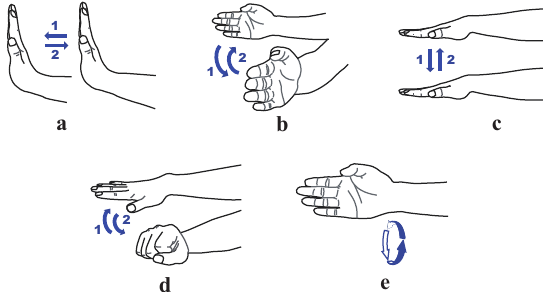
Figure 2. The five hand gestures: ( a ) pushing and pulling (PP), firstly pushing your hand to the front and then pull it back; ( b ) waving left and right (WLR), firstly waving your hand to the left and then to the right; ( c ) waving up and down (WUD), firstly waving your hand up and then down; ( d ) stretching each finger (SF), pushing your hand and at the same time stretching each finger; and ( e ) circling clockwise (CC), using your hand to draw circle with a clockwise